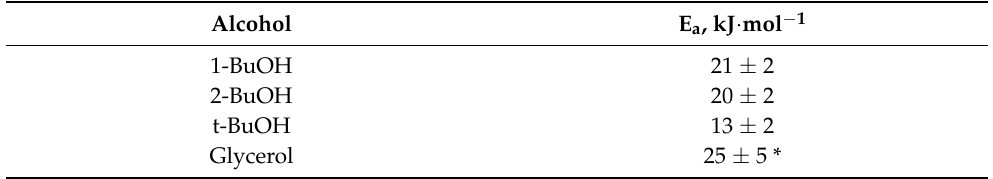
Table 1. The apparent activation energy of H 2 photocatalytic formation for BuOH isomers (0.5 M) irradiated with an Xe lamp in the presence of Ti@TiO 2 NPs under Ar flow.